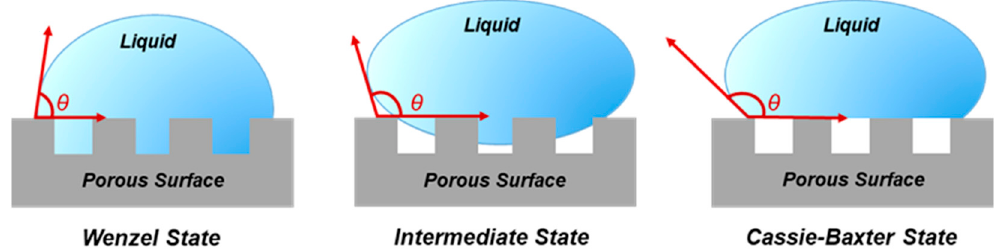
Figure 6. Schematic representation of the wetting states of a liquid droplet on non-planar surfaces.